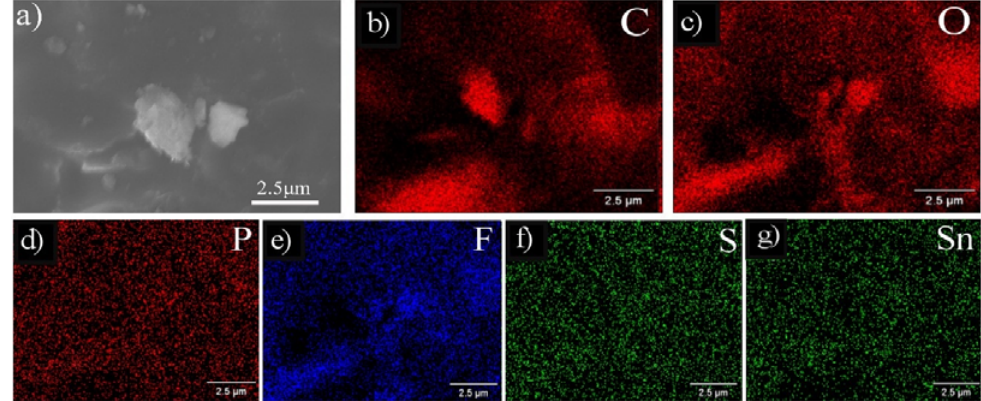
Figure 7. FESEM images of ( a ) 10SnS/AG, ( b – g ) EDS mapping of the area in ( a ). The element being mapped is indicated in each image.